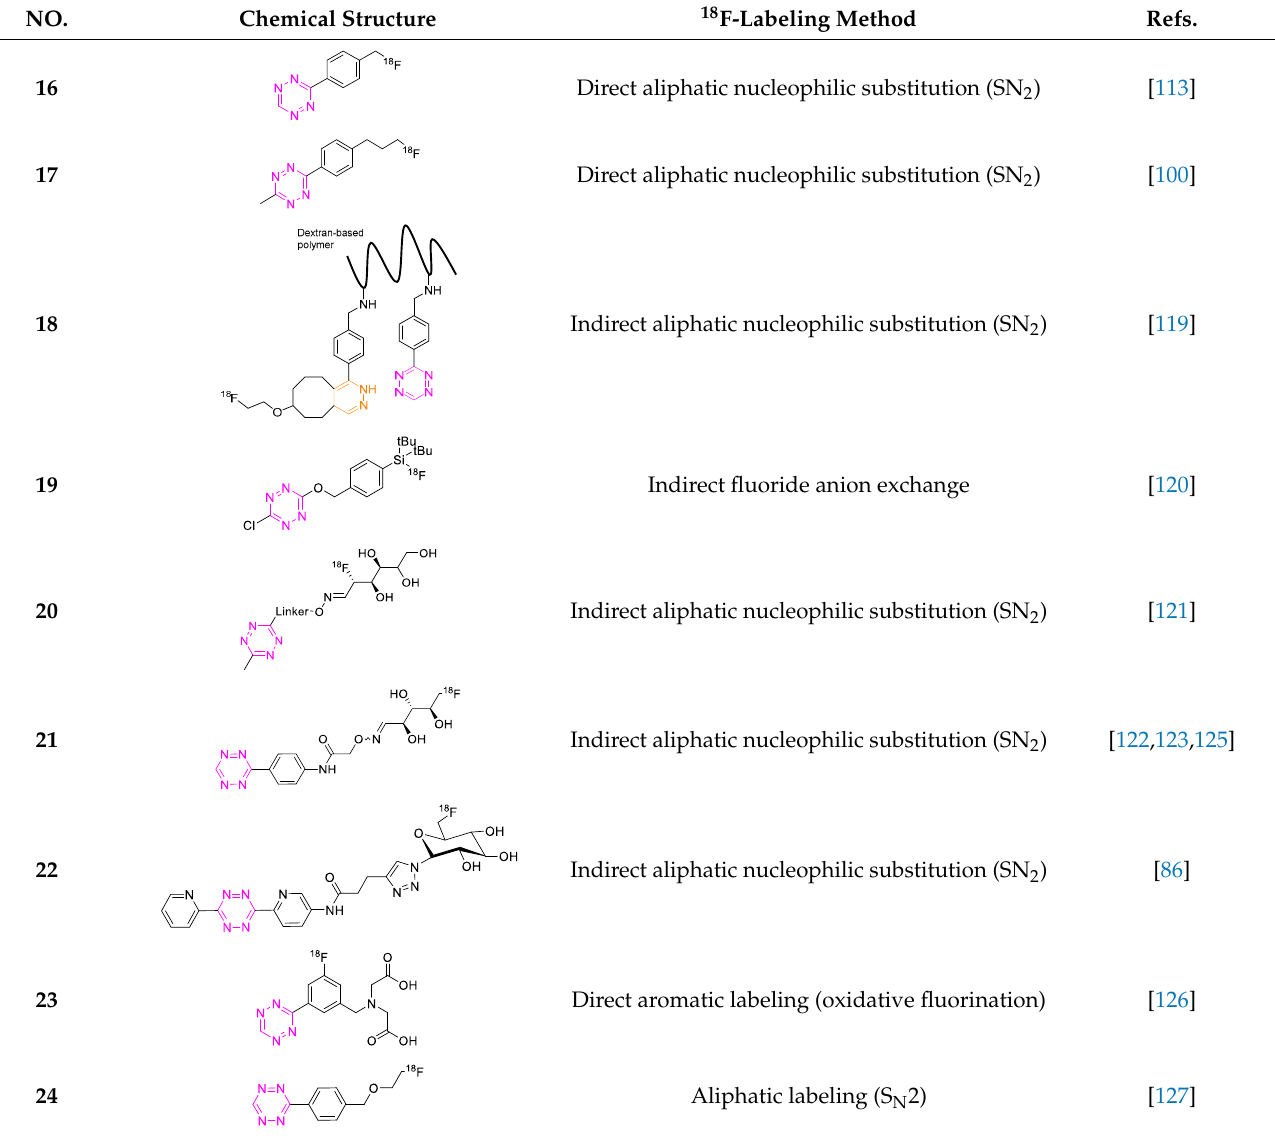
Table 4. Overview of 18 F-labeled Tzs from 2013–2021 (List is not exhaustive).